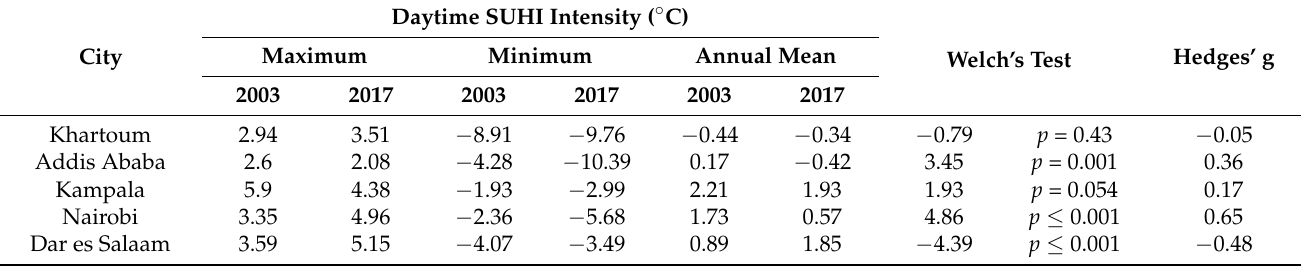
Table 4. Summary of annual daytime SUHI intensity